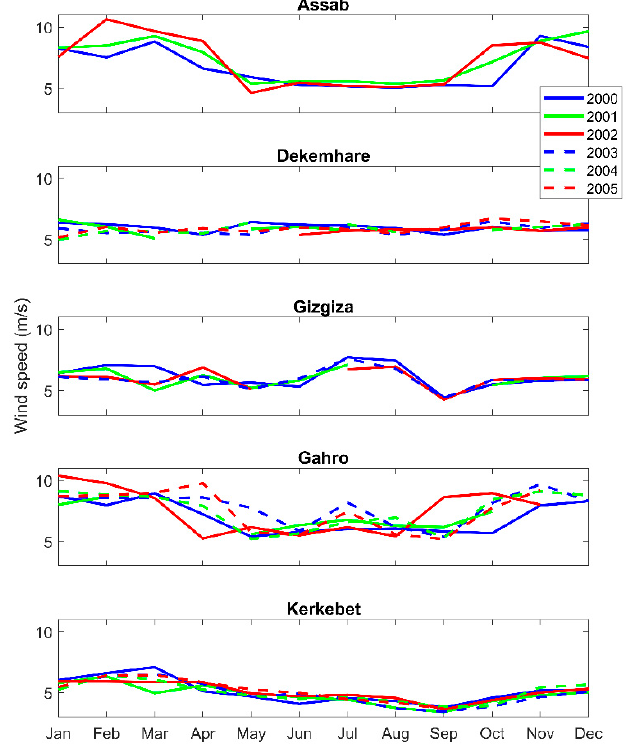
Figure 6. Mean wind speed per months for years 2000–2005 for the five sites deemed as most potential. Months with insufficient data are left out.